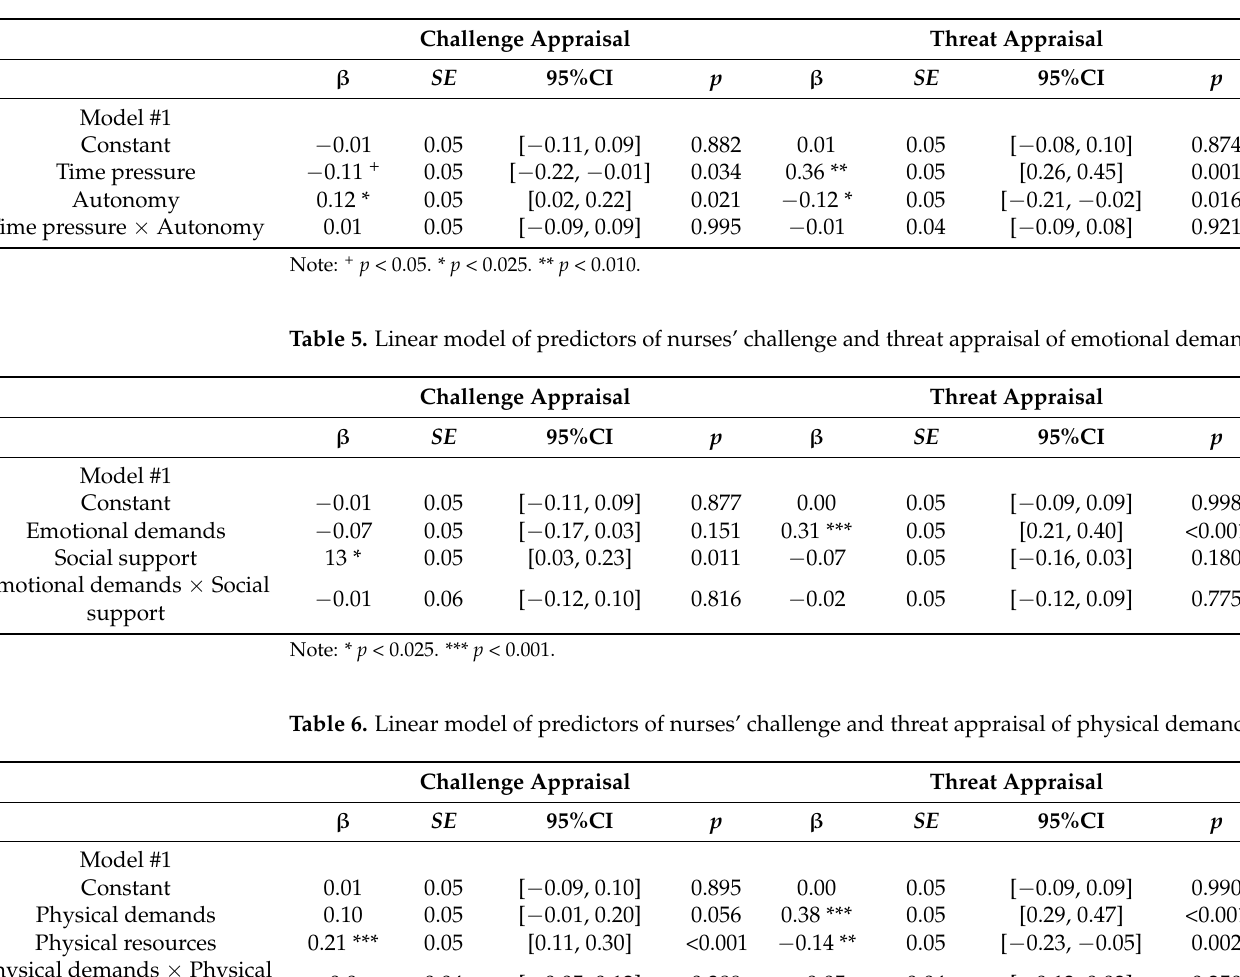
Table 4. Linear model of predictors of nurses’ challenge and threat appraisal of time pressure.